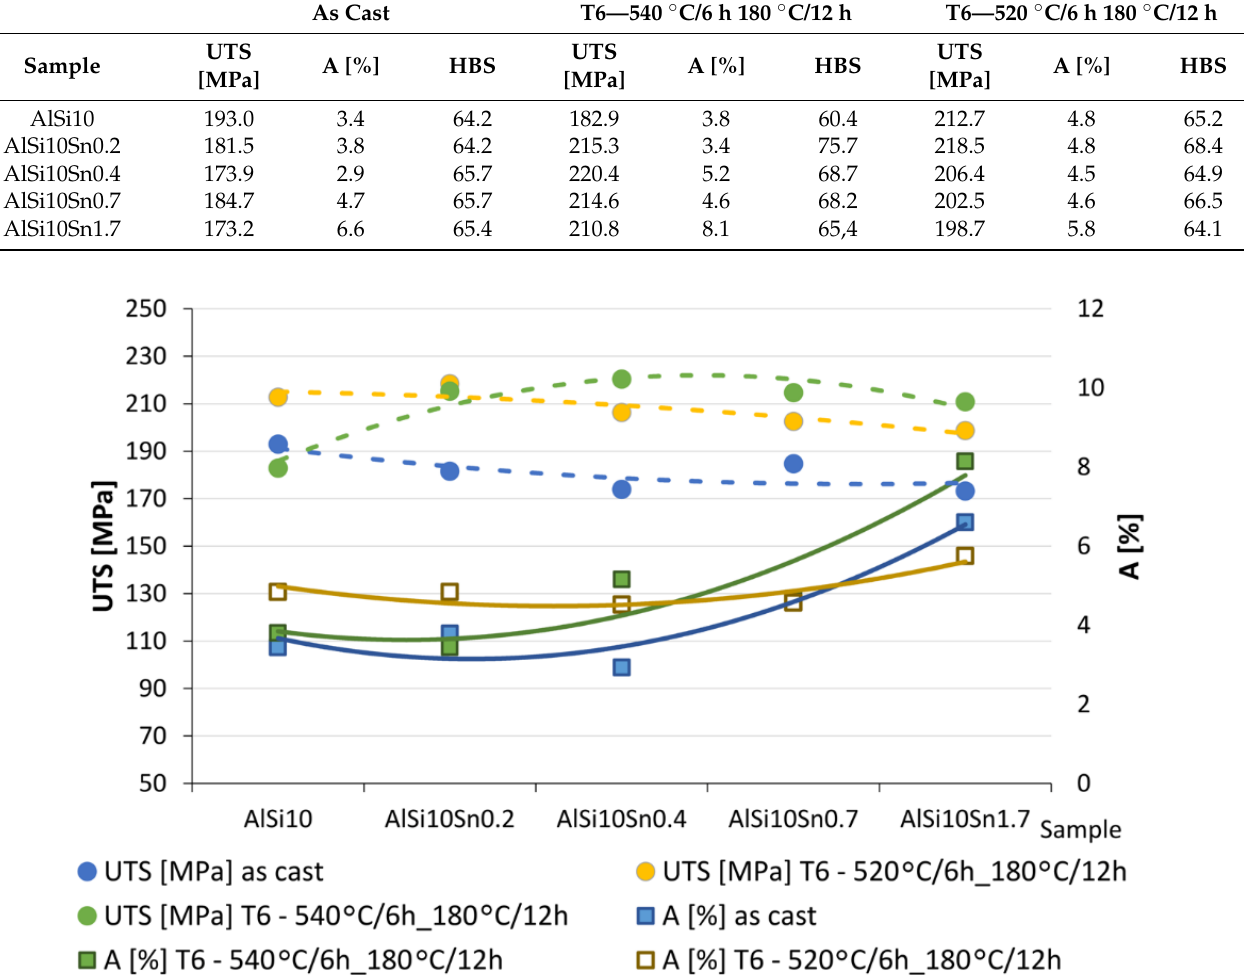
Table 10. Results of the tests of tensile strength (UTS) and elongation (A) for AlSi10 alloys with variable tin additions—as cast and T6 (solution heat-treated and fully artificially aged).